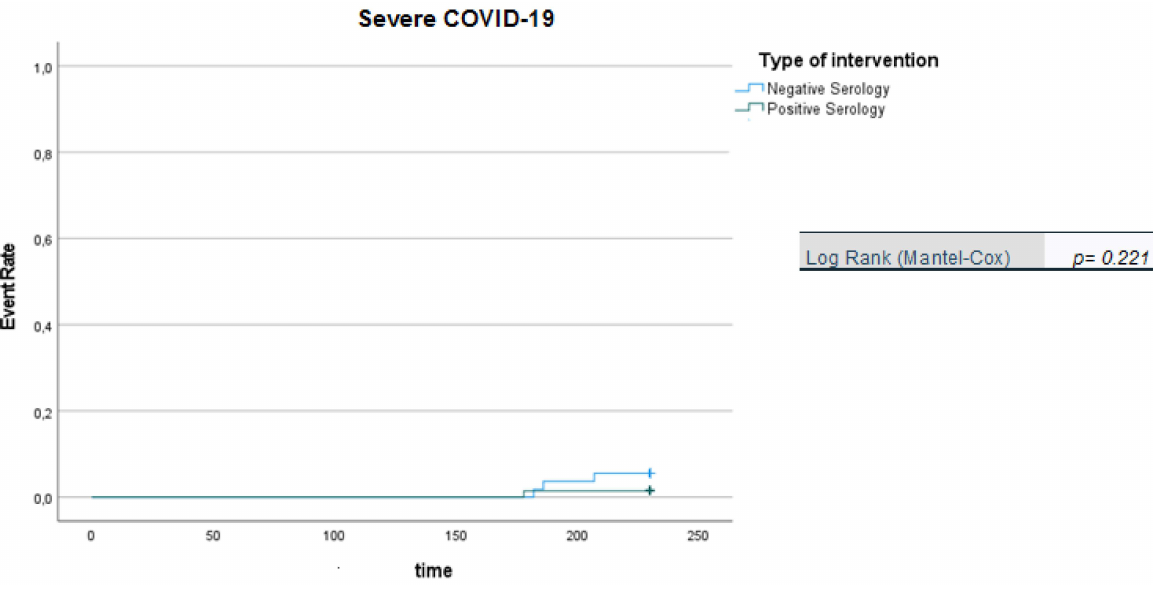
Figure 3. Kaplan-Meier curves: positive vs. negative serology in Severe COVID-19 (in